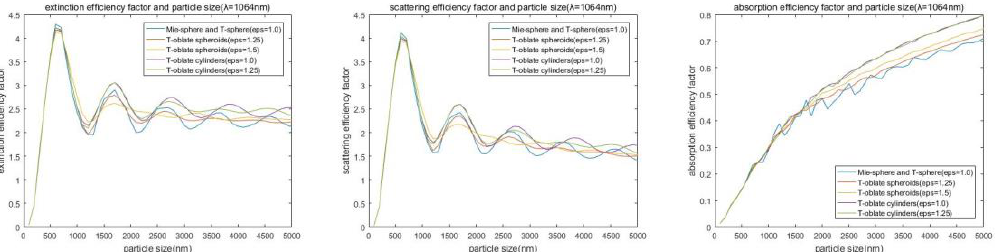
Figure 5. The extinction efficiency factor (left), scattering efficiency factor (middle) and absorption efficiency factor (right) of sphere, oblate sphere and oblate cylinder under the diameter 0 ~ 5um were compared by T-matrix method and Lorenz-Mie theory (The wavelength was 1064nm and the refractive index was 1.55+0.01i)